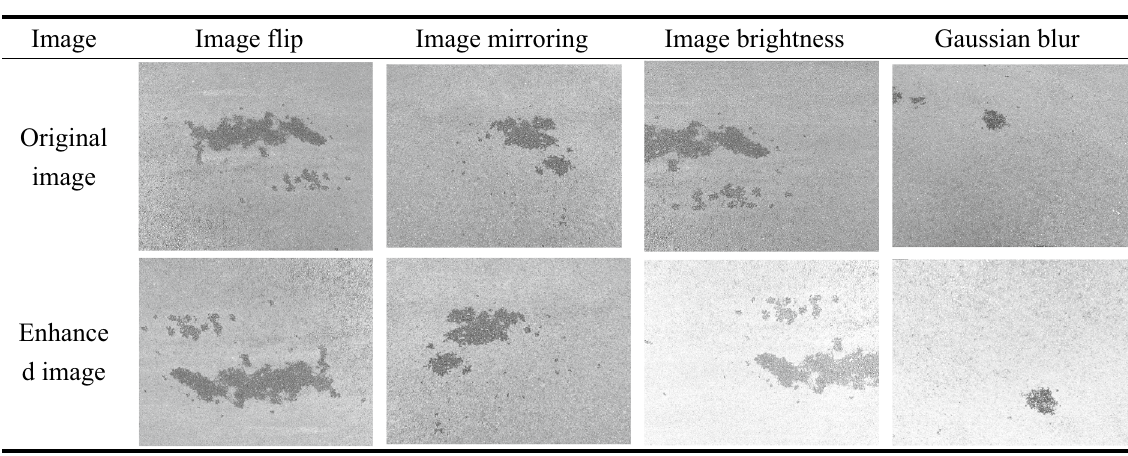
Table 1. Data set